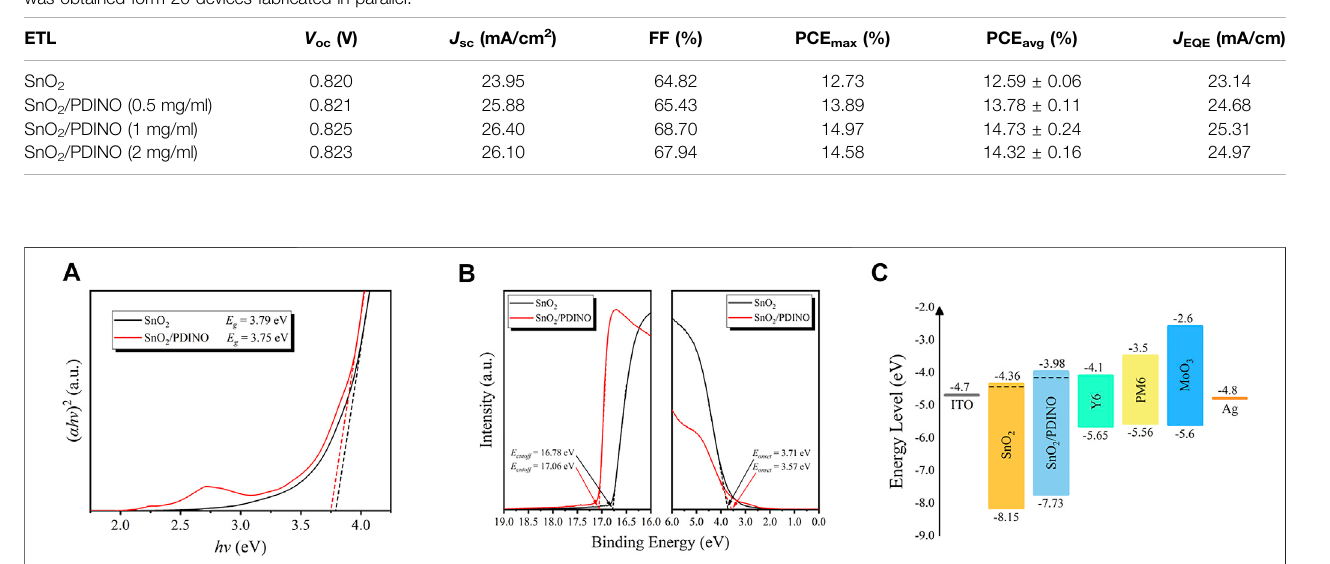
FIGURE 5 | (A) Tauc plots of SnO 2 and SnO 2 /PDINO fi lms. (B) UPS spectra of SnO 2 and SnO 2 /PDINO. (C) Schematic diagram of energy levels of OSCs with different